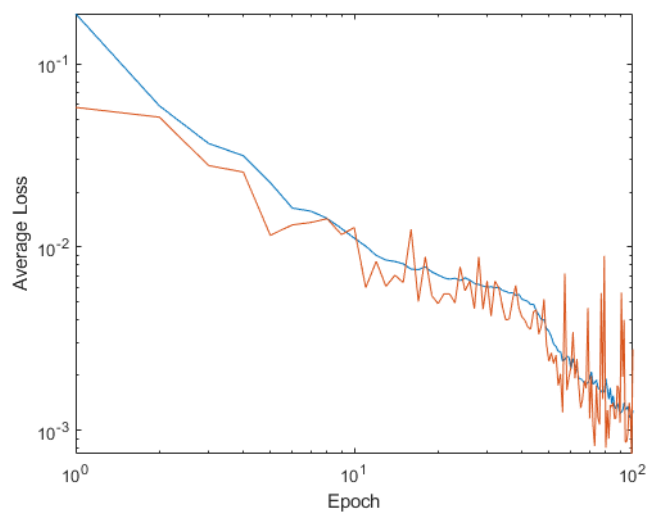
Figure 31. Average loss on training patterns in blue and validation patterns in orange for Dynamic alpha and Dynamic Drop-out mixed together SGD of Goldstein Prize function.